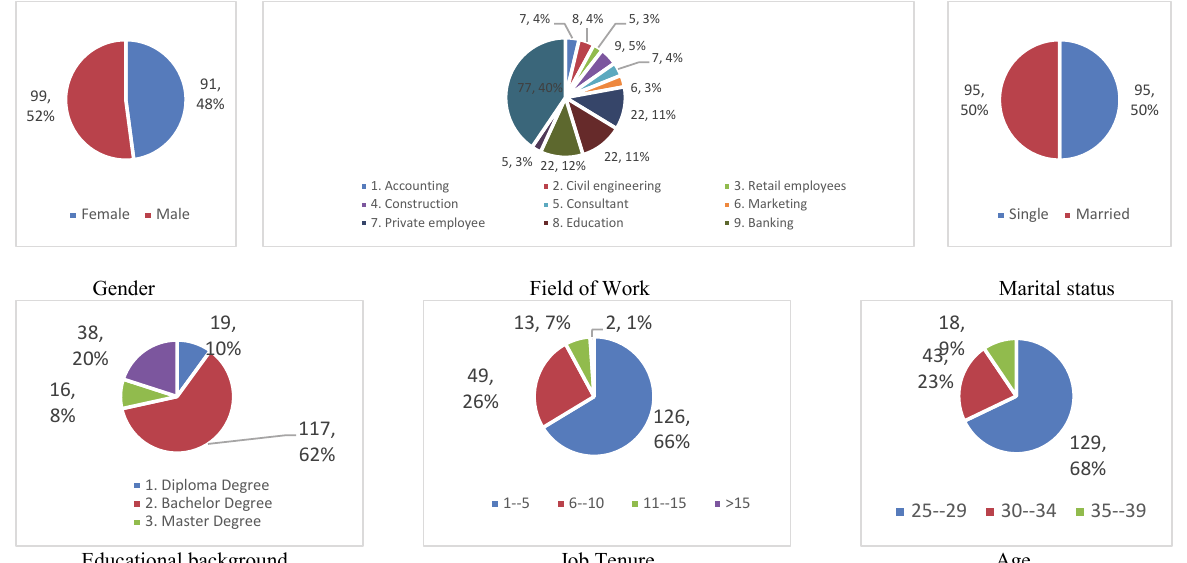
Fig. 2. Personal characteristics of the